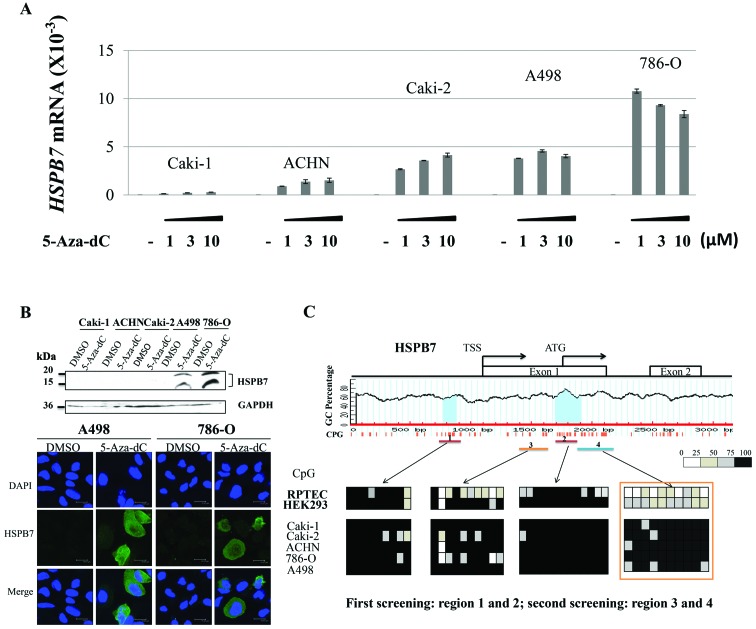
Epigenetic silencing of HSPB7 in RCC cell lines. (A) qPCR analysis and (B) western blot and ICC analysis of HSPB7 were performed in five RCC cell lines with treatment of the demethylating agent 5-Aza-dC. B2M was used for normalization of mRNA expression levels. GAPDH was used for normalization of protein expression levels. Values are expressed as the mean ± SD. (C) Hypermethylation of HSPB7 was confirmed by means of bisulfite sequencing. For each of the regions 1–4 in the cell lines, 10 or more colonies were randomly chosen and sequenced. Each square indicates a CpG site, and an average methylation level per CpG site is indicated by % methylation (shown in different color): white, 0–25% methylation; bright grey, 26–50% methylation; dark grey, 51–75% methylation; and black, 76–100% methylation. Region 4 showed higher level of methylation in the five RCC cell lines (Caki-1, Caki-2, ACHN, 786-O and A498) than in the two control cell lines (RPTEC and HEK293).